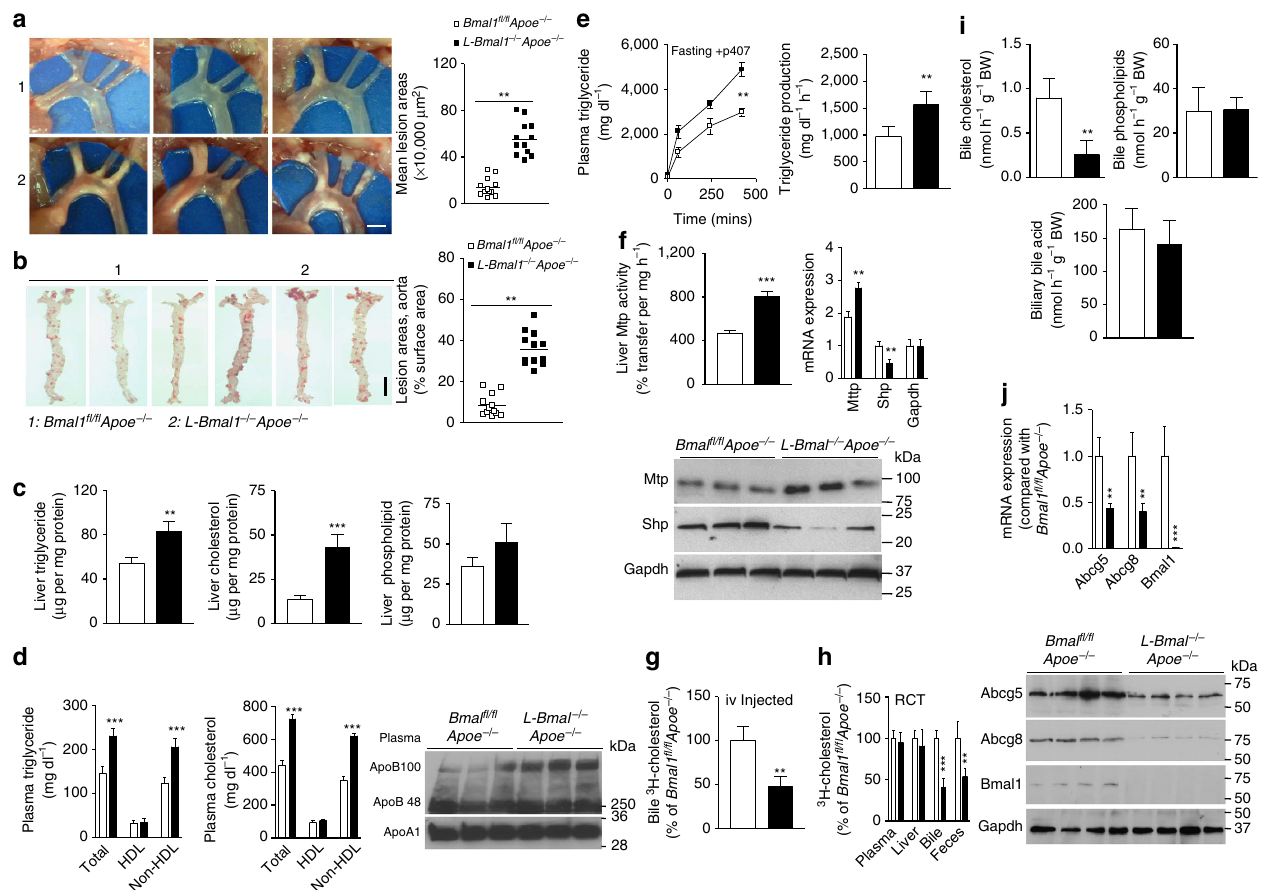
Figure 3 | Effects of liver-specific Bmal1 ablation in Apoe (cid:2) / (cid:2) mice. Bmal1 fl/fl Apoe (cid:2) / (cid:2) (white square) and L-Bmal1 (cid:2) / (cid:2) Apoe (cid:2) / (cid:2) (black square) male mice were fed a chow diet for 8 months. ( a ) Mice were dissected to visualize atherosclerotic lesions at the aortic arch and photographed (right). Plaque areas were quantified and graphed (left) and a representative cardiac-aorta stained with Oil Red O for lesion areas were quantified (right). Scale bar, 2mm. ( b ) Whole aortas were stained with Oil Red O (left), and lesions were quantified (right). Scale bar, 5mm. ( c ) Hepatic lipids were quantified and normalized to protein for comparison. ( d ) Triglyceride and cholesterol were measured in total plasma and in HDL after precipitating apoB-lipoproteins. Non-HDL values were deduced after subtracting HDL from total (left). Plasma apoB and apoAI were analysed by western blotting (right). ( e ) Hepatic lipoprotein production was studied after injecting P407 in 5h fasted animals. Increases in plasma triglyceride (left) and production rates (right) were plotted. ( f ) MTP activity in liver homogenates (left), and mRNA levels of Mttp and Shp (right). Hepatic protein levels of MTP, Shp and Gapdh were detected by western blotting (bottom). ( g ) Mice were injected with 3 H-cholesterol. Amounts of cholesterol were quantified in gall bladder bile. ( h ) J774 macrophages were incubated with 5 m Ciml (cid:2) 1 of 3 H-cholesterol with AcLDL (50 m gml (cid:2) 1 ) for 24h. Cells were detached, washed and placed in the peritoneum of different mice. Amounts of cholesterol found after 48h in the plasma, liver, bile and feces are shown. ( i ) Cholesterol, phospholipid and bile acid were quantified in the bile. ( j ) mRNA (top) and protein (bottom) levels of Abcg5 and Abcg8 were quantified. Data in a and b were analysed by one-way ANOVA ( n ¼ 12 mice per group). Data in c , d and f – j were evaluated using the unpaired Student’s t -test ( n ¼ 12 per group). Data in e were examined via two-way ANOVA ( n ¼ 4). Values are mean ± s.d. * P o 0.05, ** P o 0.01 and *** P o 0.001. Error bars represent